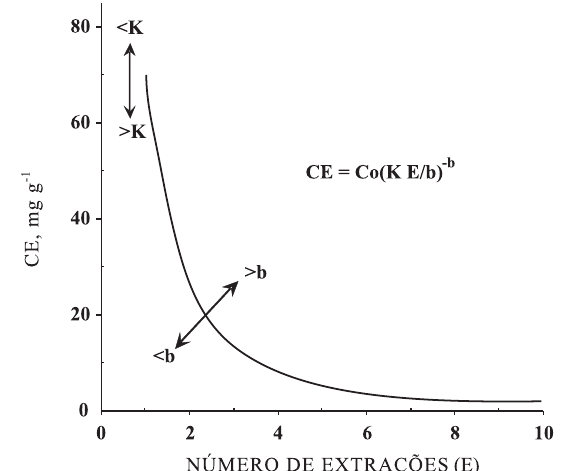
Figura 1. Forma da curva de cinética do teor de P recuperado pela resina de troca aniônica como variável do número de extrações sucessivas deste elemento pela resina, e sua dependência às variações das constantes K e b (uma simulação). CE é o P recuperado pela resina de troca aniônica em mg kg -1 , Co é o P aplicado, K é a taxa de dessorção de P, E é o numero de extrações sucessivas e b é uma Quadro 6. Coeficientes de correlação linear simples entre teores de caulinita (Ct), gibbsita (Gb), goethita (Gt), carbono orgânico (CO) (dag/kg), argila (Arg), ferro (Fe) e alumínio (Al) (dag/kg) com capacidade máxima de adsorção de fosfatos (CMAP) (mg g -1 ) de amostras de solos sem redução